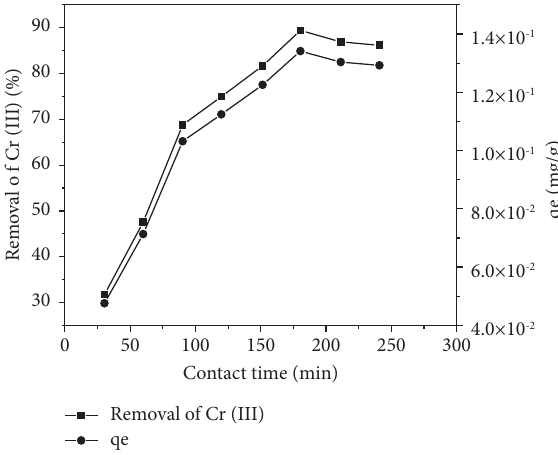
Figure 3: Efect of contact time on Cr (III)